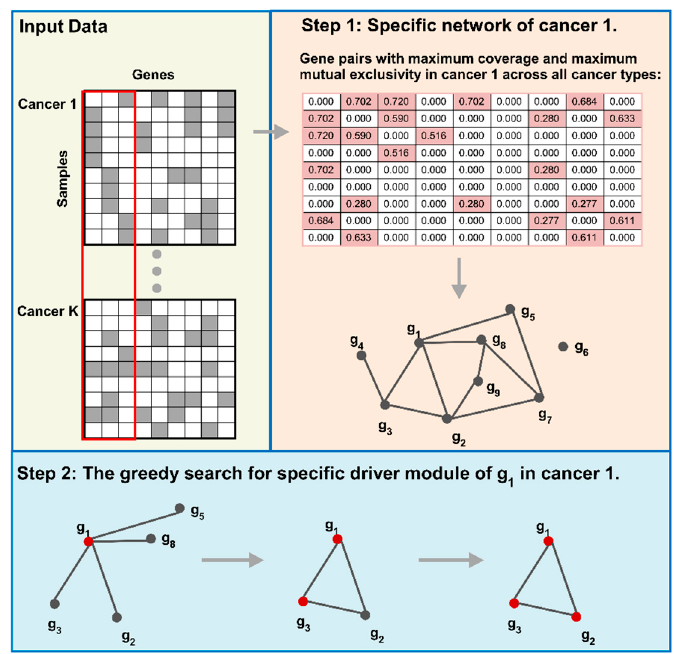
Figure 6. Overview of CSDM. Firstly, we use the binary matrix to represent the mutation data. Then, we construct the specific network for a certain cancer type to other cancer types. At last, we use a greedy search to detect cancer specific driver modules for a certain cancer type.